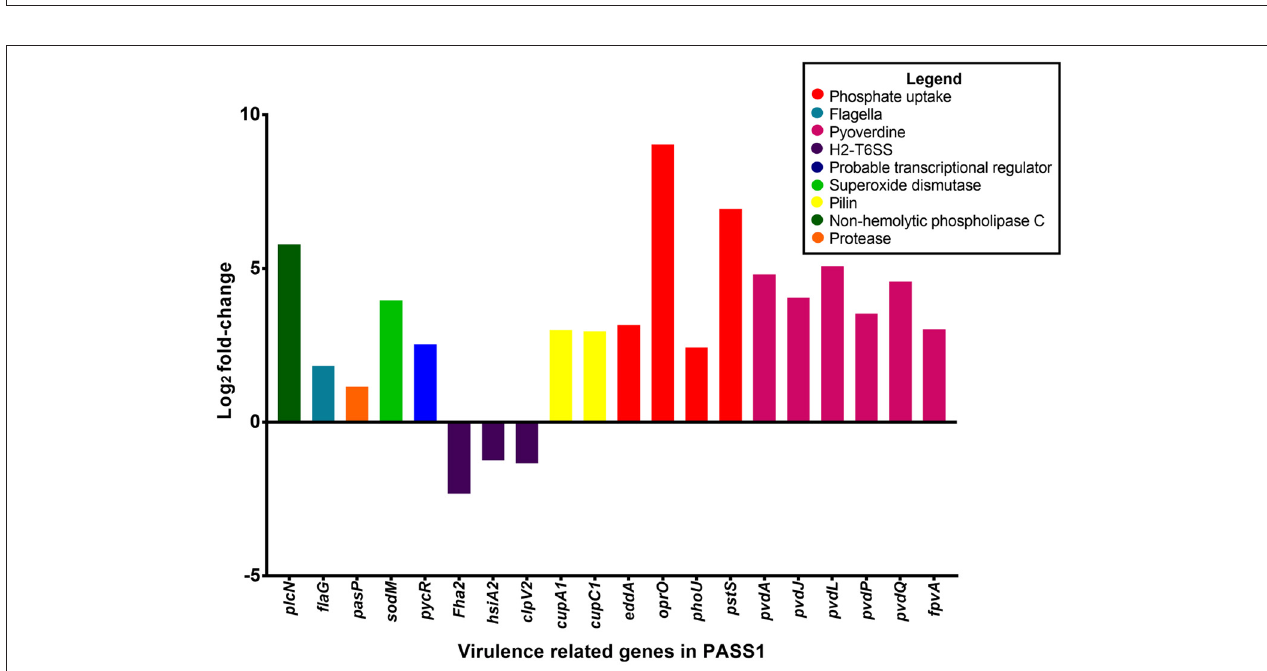
FIGURE 4 | Differential gene expression of virulence-related genes of P. aeruginosa PASS1 during infection of zebrafish compared to PASS1 cells grown in Luria-Bertani medium. Log 2 fold-change differential expression of known virulence genes ( p ≤ 0.01 and log 2 fold-changes cut-off − 1 ≥ to ≤ 1).